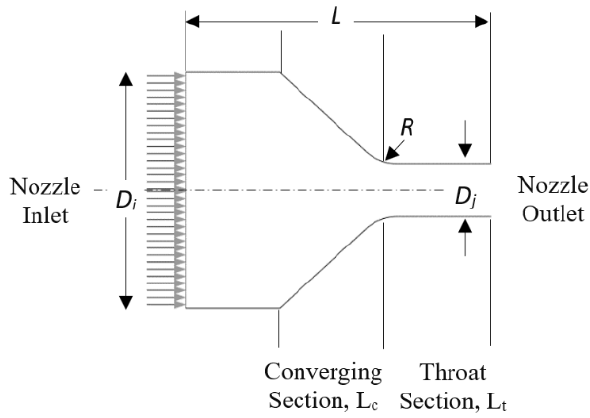
Figure 2. Geometry of the converging-barrel nozzle. Table 1. Main dimensions of the converging-barrel nozzle.